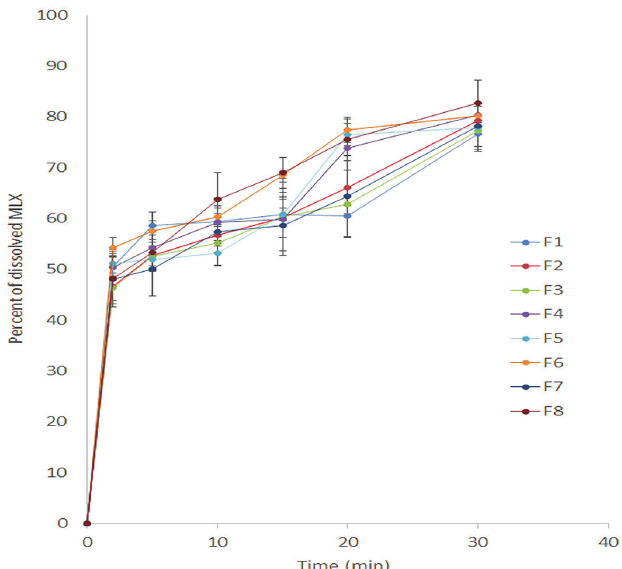
FIGURE 5 - The dissolution profiles of the prepared MLX